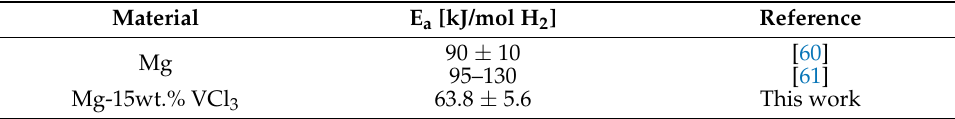
Table 4. The activation energy of the hydriding